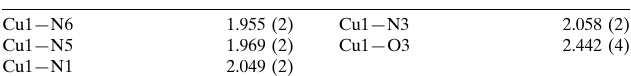
Selected bond lengths (A˚ ).